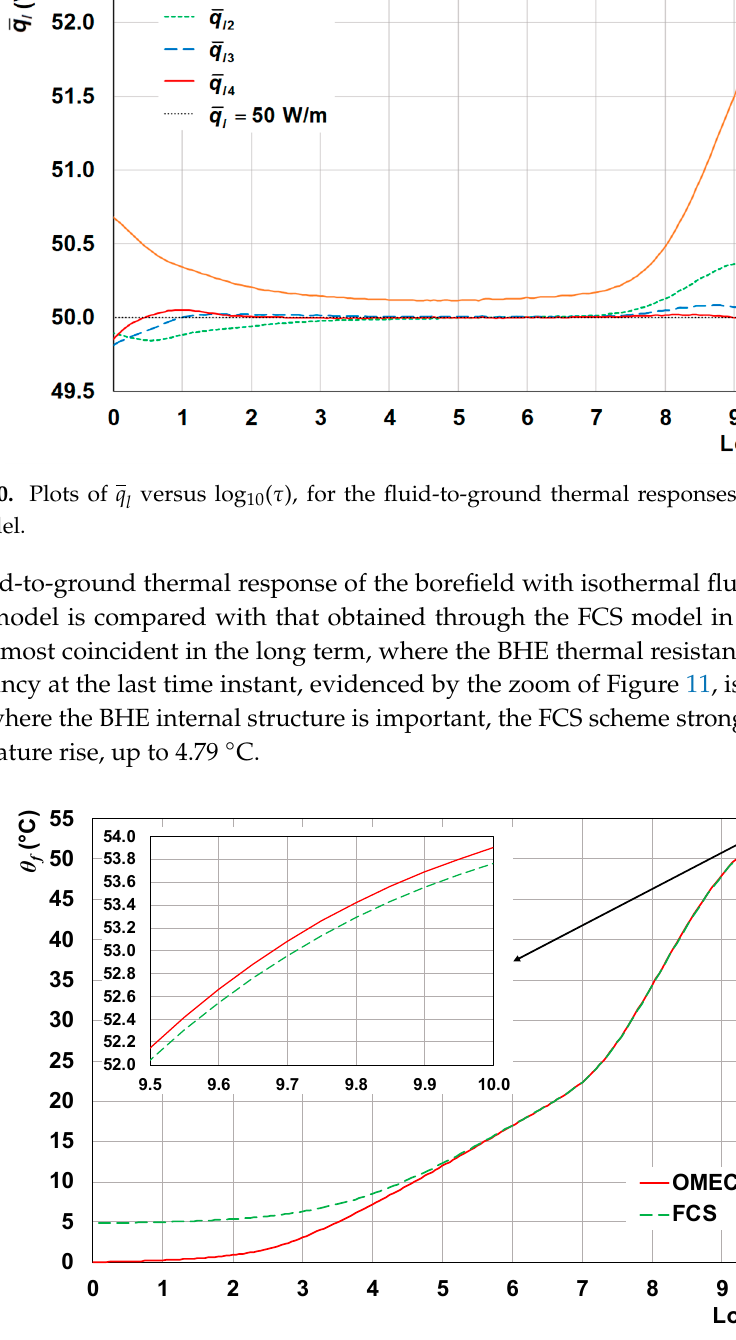
Figure 11. Isothermal fluid-to-ground thermal response of the 2 × 2 borefield versus log 10 ( τ ), OMEC model and FCS model.